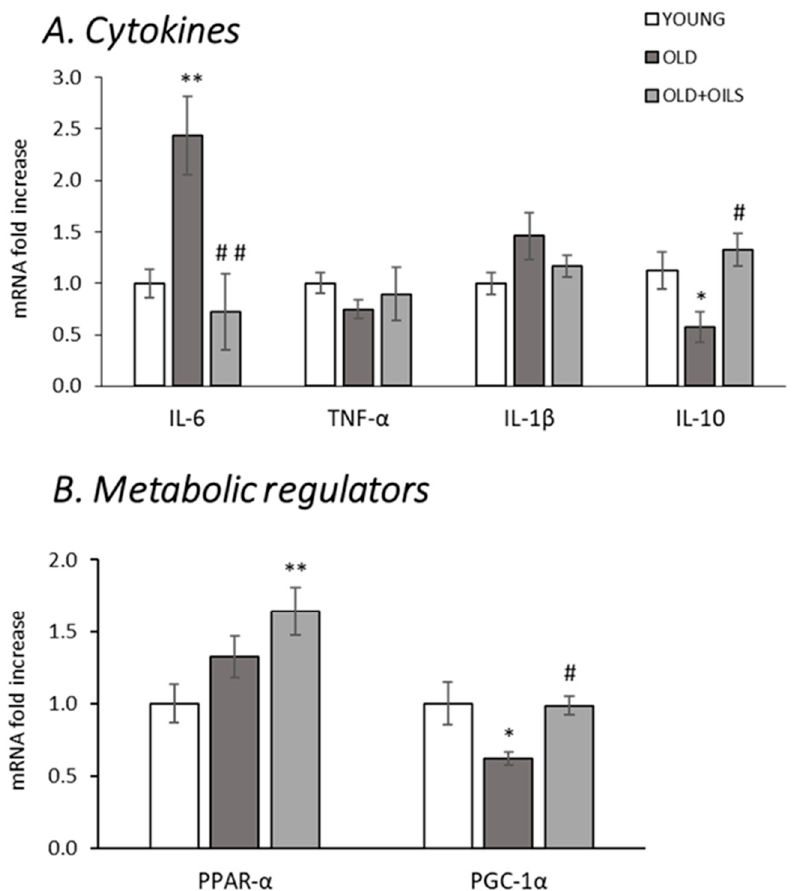
Figure 2. Oil mixture treatment improved the inflammatory profile and the expression of metabolic regulators in old gastrocnemius muscle. Figures show the mRNA levels of ( A ) interleukin-6 (IL-6), tumor necrosis factor alpha (TNF- α ), IL-1 β and interleukin-6 (IL-10), ( B ) peroxisome proliferator-activated receptor alpha (PPAR- α ), and peroxisome proliferator-activated receptor gamma coactivator 1-alpha (PGC-1 α ) of young rats ( n = 11), old rats ( n = 8), and old rats treated for 21 days with the oil mixture (OLD + OILS, n = 5). Values are represented as mean ± standard error of the mean (SEM). Statistics: ** p < 0.01 and * p < 0.05 vs. Young; ## p < 0.01 and # p < 0.05 vs. Old, by least-significant difference post hoc analysis after significant one-way analysis of variance (ANOVA).